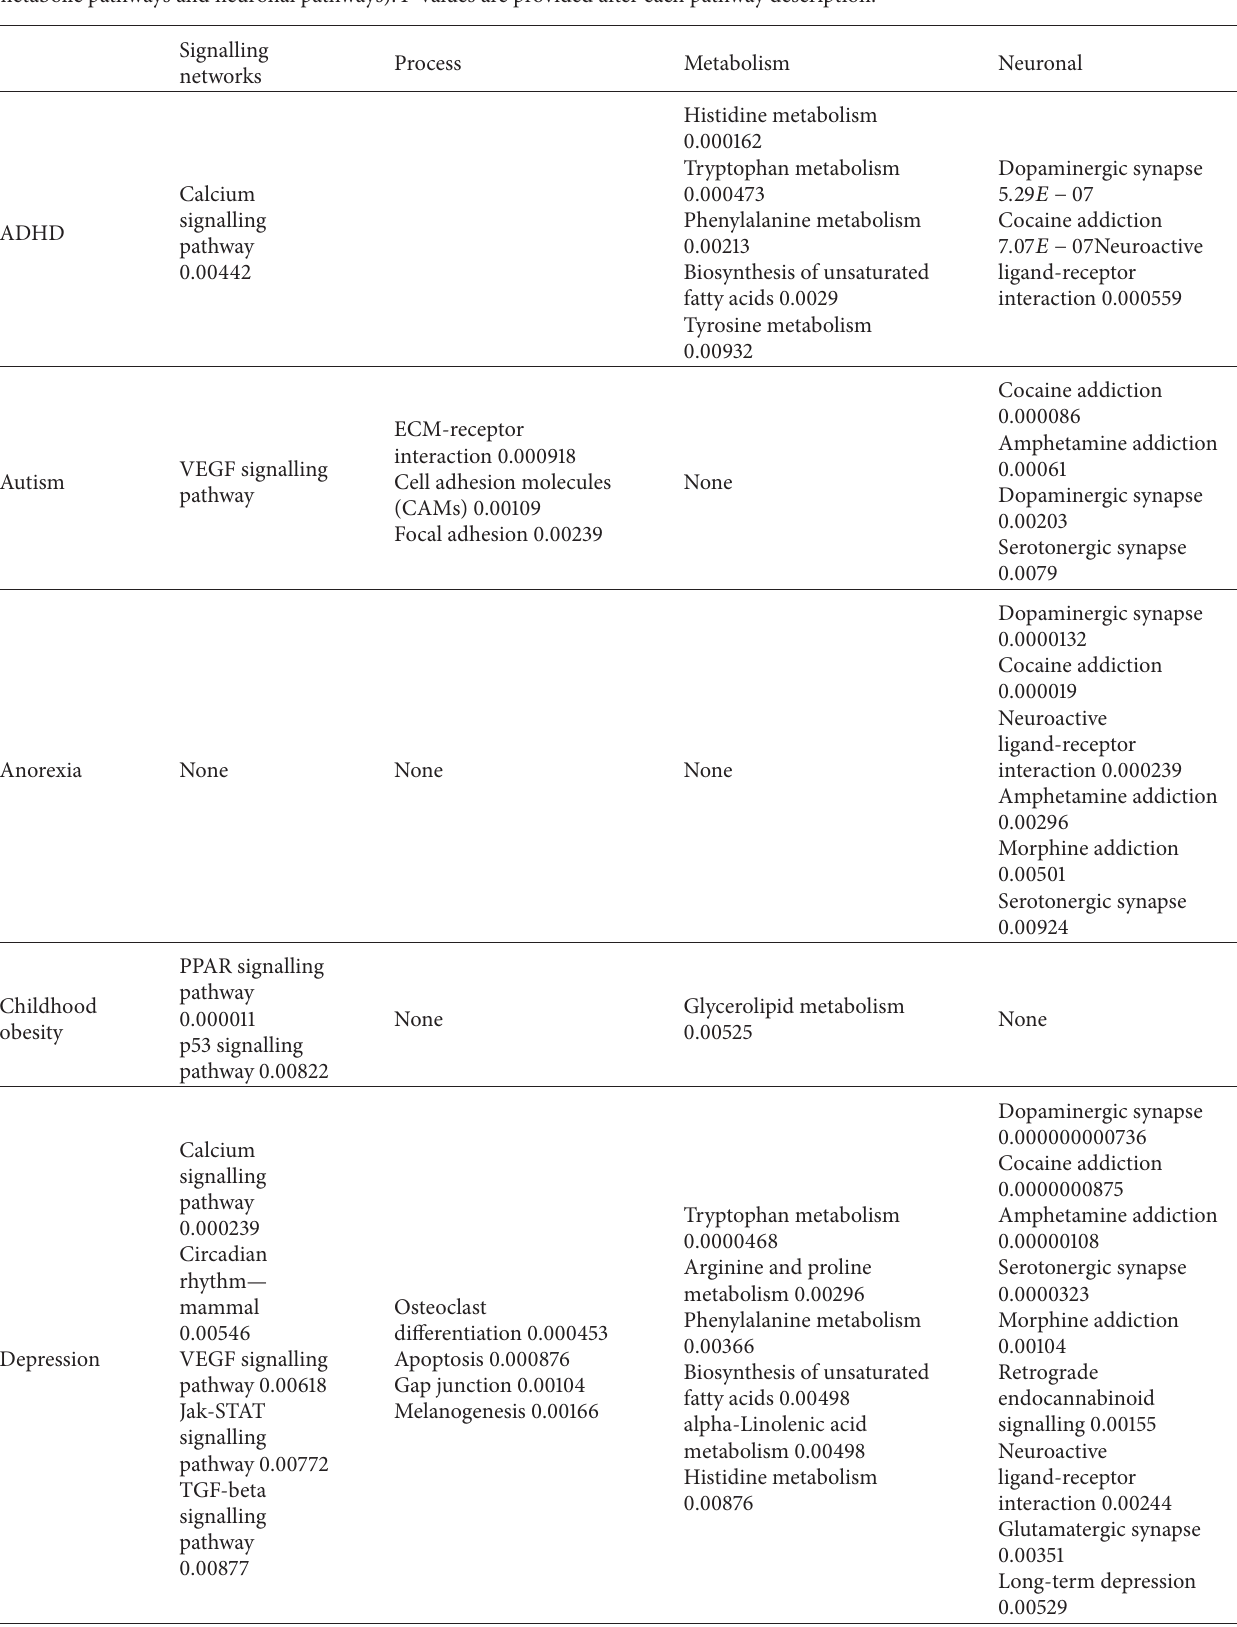
Table 6: Significantly enriched KEGG pathways within the overlapping interactome/susceptibility gene datasets (Signalling networks, metabolic pathways and neuronal pathways). 𝑃 values are provided after each pathway